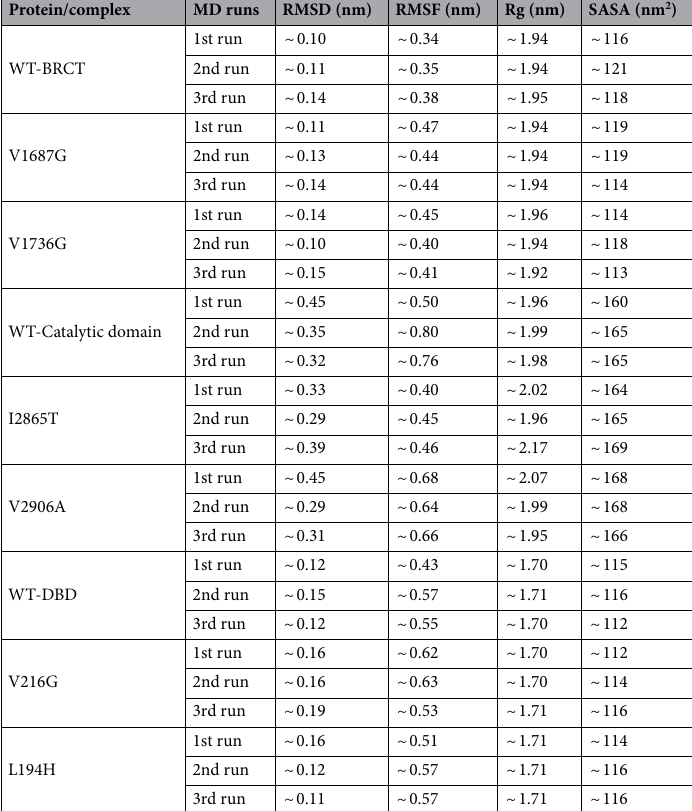
Table 6. The average values of RMSD, RMSF, Rg and SASA for WT and mutant proteins.